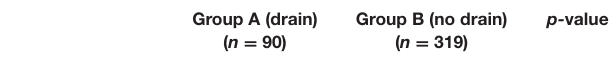
TABLE 1 | Pre- and intra-operative data for patients undergoing laparoscopic cholecystectomy (LC).